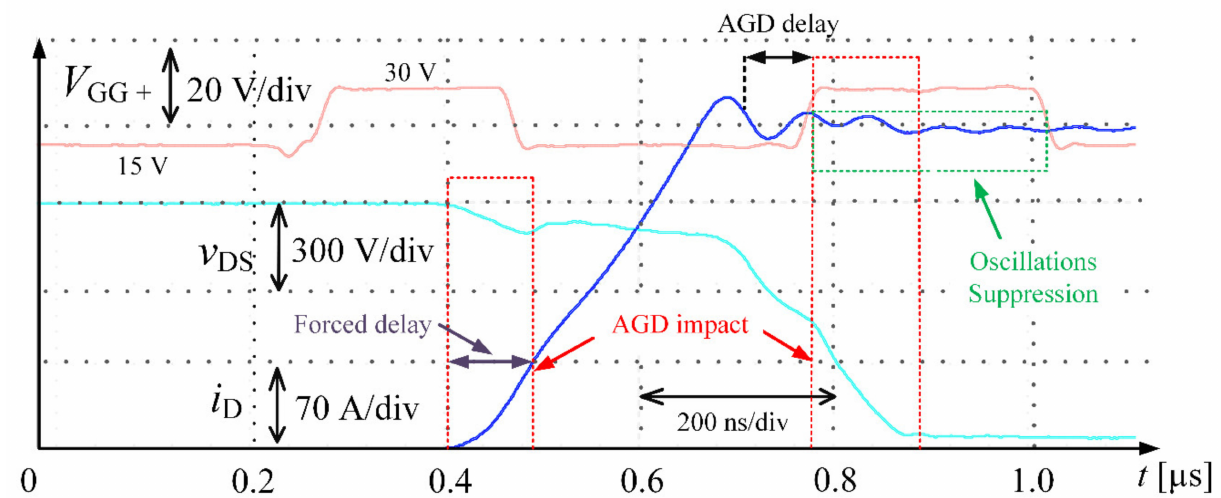
Figure 12. The turn-on cycle of the SiC MOSFET from module CAS300M17BM2 using AGD with the V GG + voltage waveform. V DD = 900 V, I 0 = 270 A.